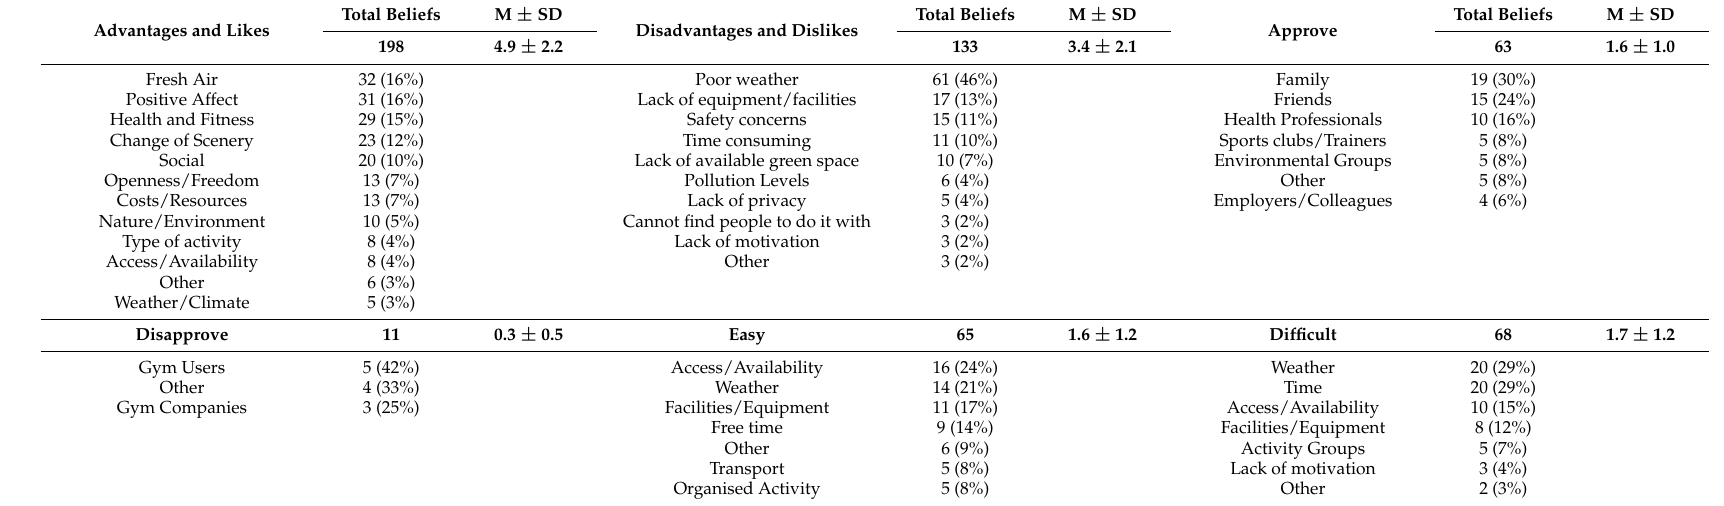
Table 1. Descriptive statistics for the salient beliefs elicited in Study